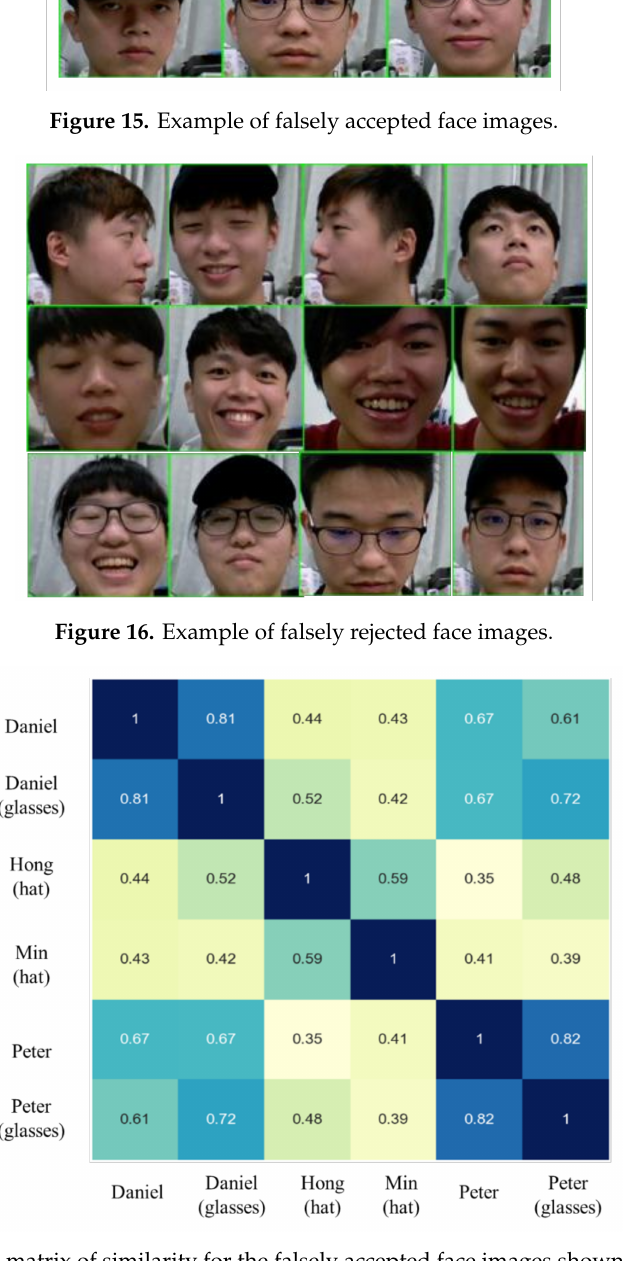
Figure 17. The matrix of similarity for the falsely accepted face images shown in Figure